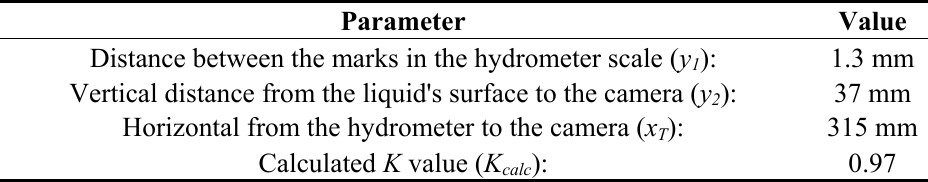
for the medium accuracy Table 4. K calc